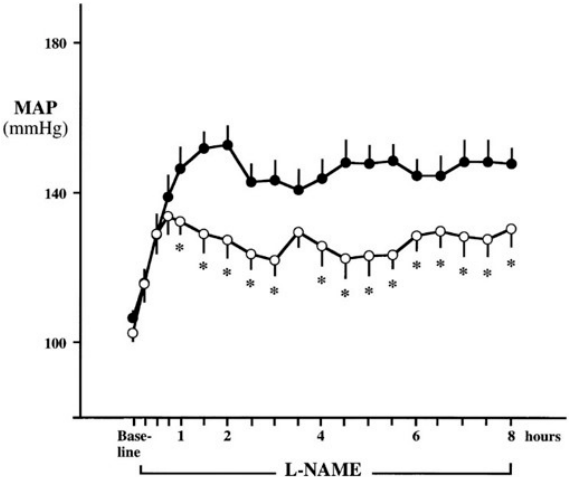
Figure 3. Mean arterial pressure (MAP) responses during 8-h continuous systemic infusion of the nitric oxide synthase (NOS) inhibitor L -nitroarginine methyl ester ( L -NAME) in rats with sympathectomy (open circles) and without sympathectomy (closed circles). Although no difference was observed in the initial increase in MAP (removal of endothelium-mediated dilation), sympathectomy attenuated the sustained hypertensive response to L -NAME, demonstrating a sympathetic contribution to the blood pressure raising effects of systemic NOS inhibition. * p < 0.05 vs. control. (From Sander et al. [75] with permission).